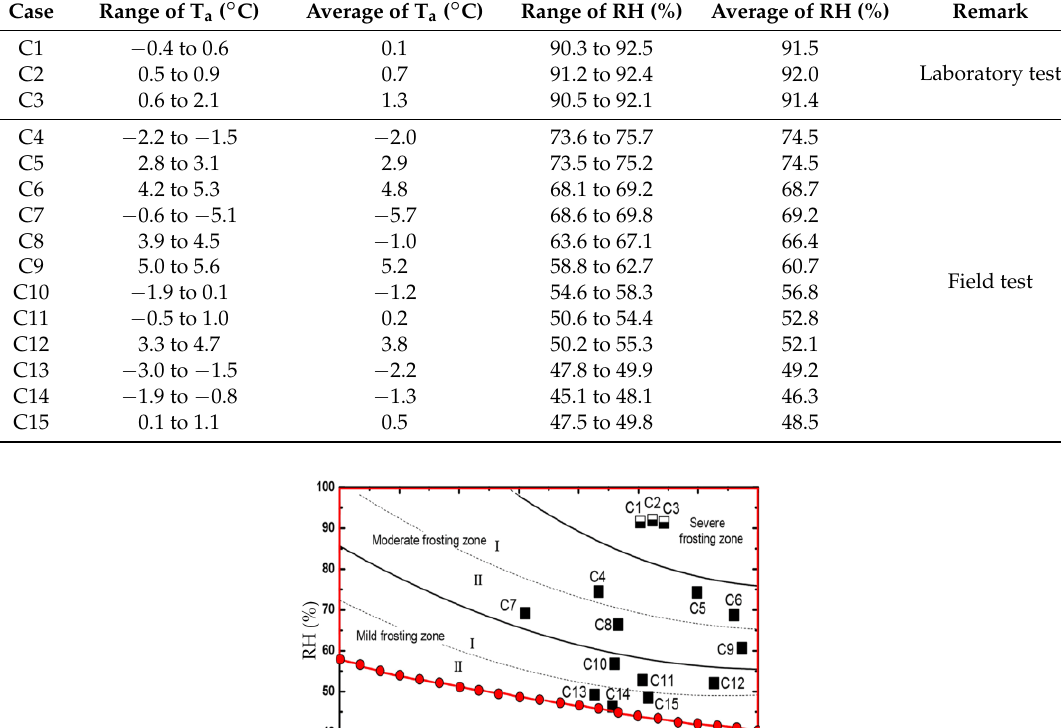
Table 2. Operation conditions of all test cases [63].